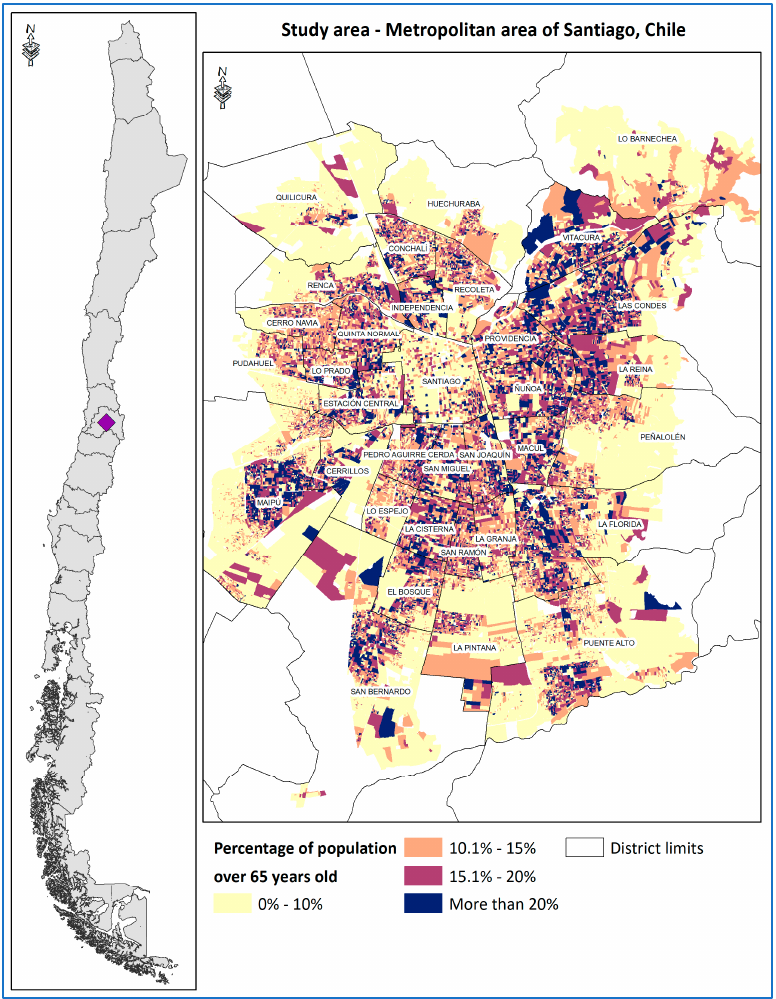
Figure 1. Study area, Metropolitan Area of Santiago, Chile. Source: [42]